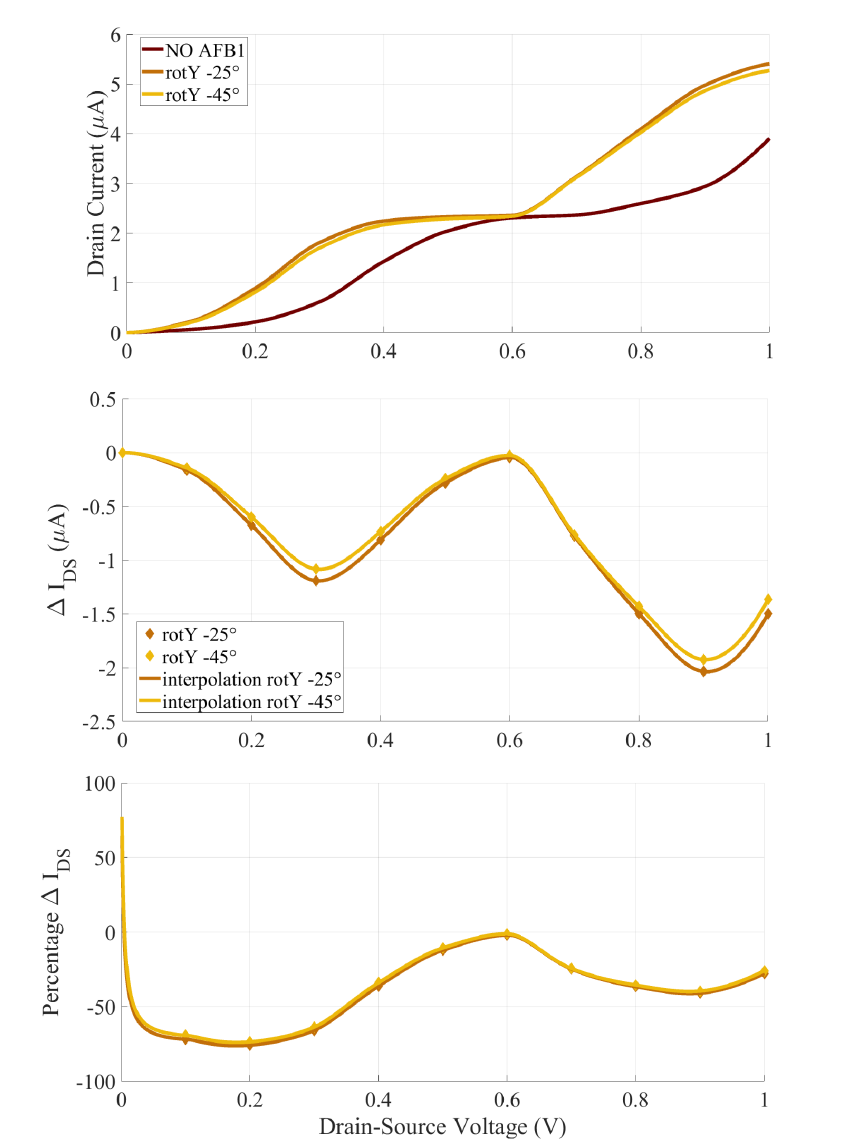
Figure 7. Computed current response of the Au-8PyDT sensor in the absence (dark red) and in the presence of the AFB1 target evaluated with null gating effect (i.e., V GS = 0